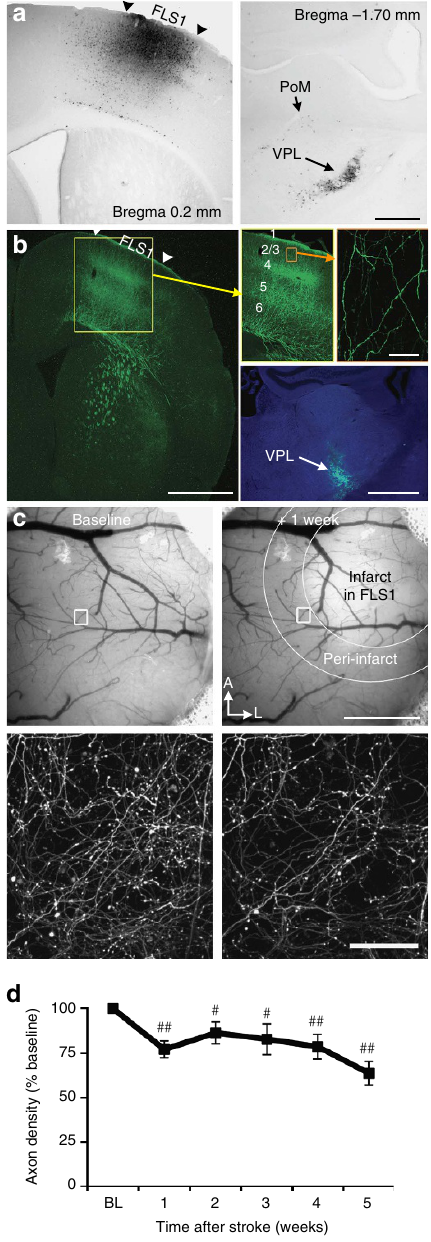
Figure 1 | Survival of peri-infarct thalamocortical projections after focal stroke. ( a ) Left, bright-field image shows cholera toxin B injection site in primary forelimb somatosensory cortex (FLS1). Right, retrograde labelling of neurons is primarily concentrated in the VPL nucleus, with sparse labelling in PoM nucleus of the thalamus. ( b ) Distribution of anterogradely labelled eGFP-expressing thalamocortical axons in the FLS1 cortex after AAV injection in the ventral thalamus (bottom right). ( c ) Bright-field images of the cortical surface before and 1 week after focal stroke in FLS1 cortex. Below each image is a maximal intensity z-projection two-photon image of thalamocortical axons in cortical layer 1 of FLS1/peri-infarct cortex. ( d ) Graph shows the density of axons after stroke relative to BL levels ( n ¼ 15 mice; # P o 0.05; ## P o 0.01 relative to BL based on one-sample t -tests). Data are means ± s.e.m. Scale bars, ( a ) 0.5mm; ( b ) 1mm (top left), 50 m m (top right), 1mm (bottom right); ( c ), 1mm (top right), 50 m m (bottom